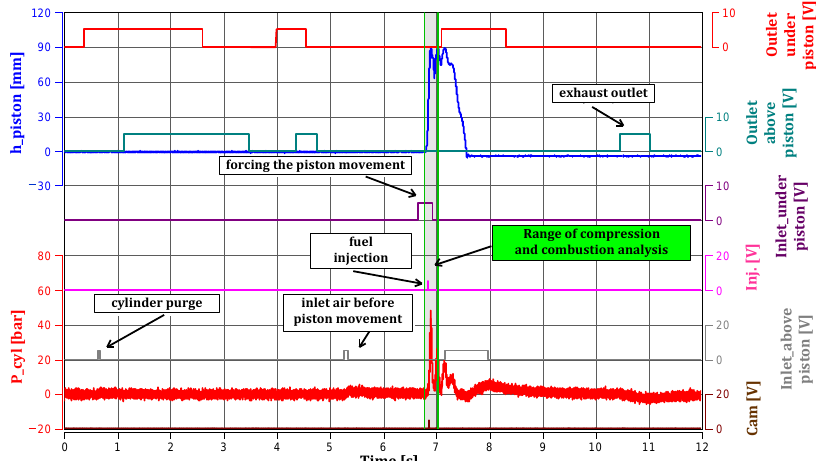
Figure 4. Range of operation of the system under analysis together with the entire sequence of operations of the electromagnetic valves.